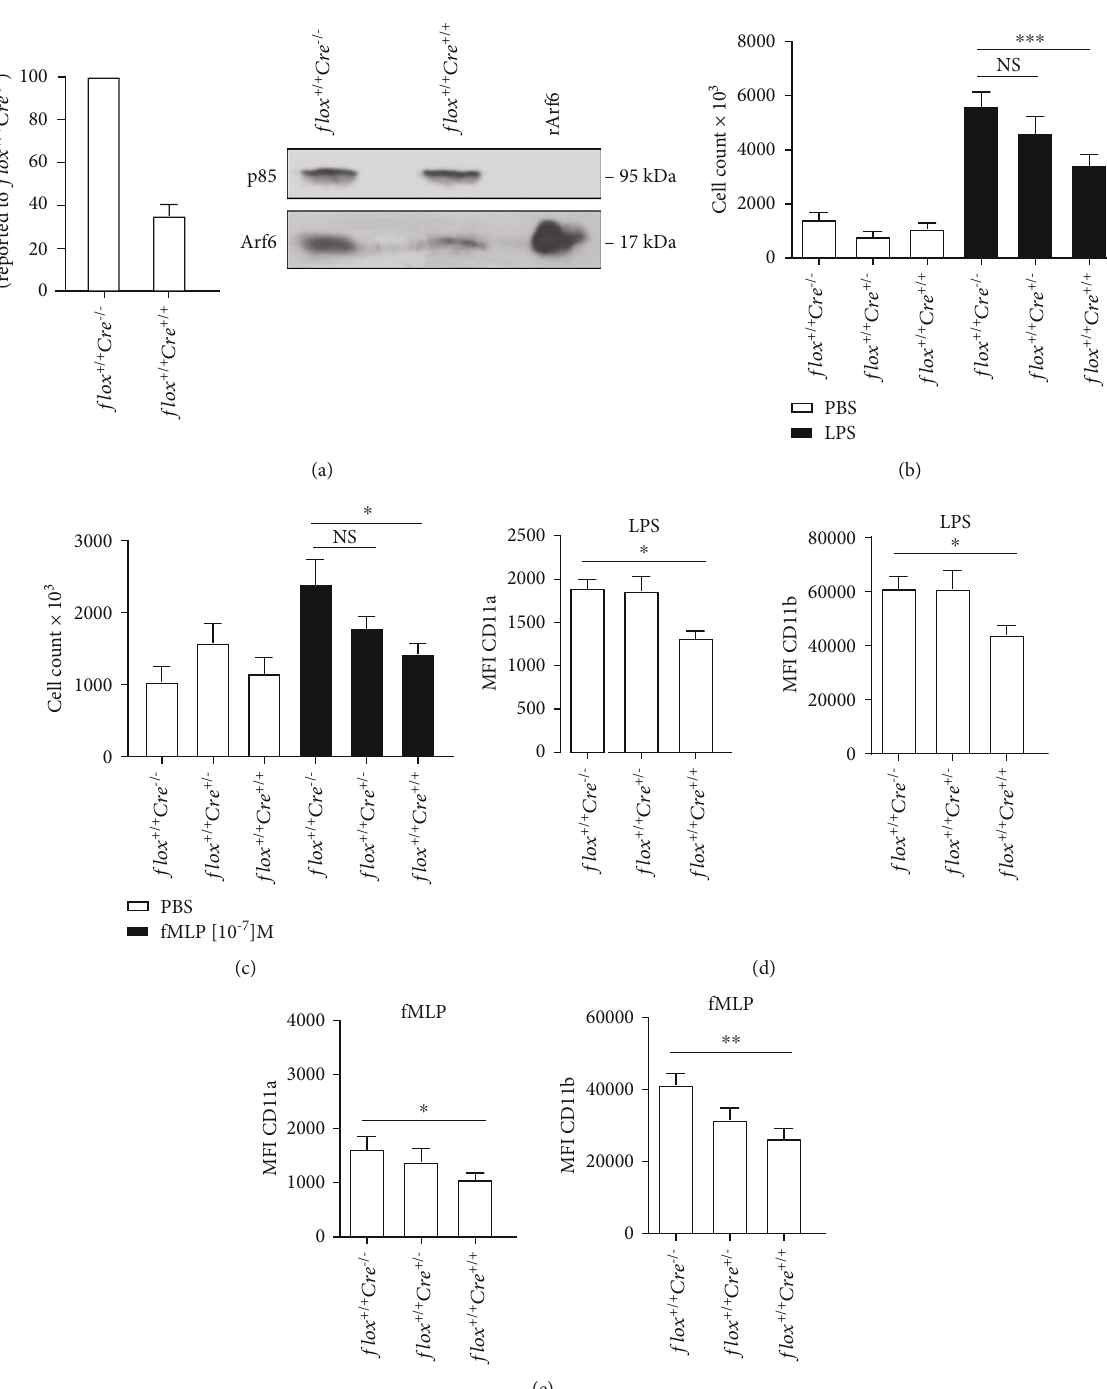
Figure 5: The deletion of Arf6 reduces PMN migration into the air pouches and cell surface expression of CD11a (LFA-1) and CD11b (Mac-1). (a) Arf6 expression by PMNs recruited into the mouse air pouches injected with LPS stimulation was analyzed by immunoblotting with Arf6 and PI3 kinase p85 alpha (p85, loading control) antibodies (left panel, n = 3 ). The right panel is a representative blot from 3 independent experiments with similar results. Recombinant Arf6 (rArf6) was used as a positive control. The amounts of PMNs recruited into the mouse air pouches injected with (b) LPS or (c) fMLP for 4 h were assessed (PBS: n = 6 mice; LPS: n = 30 -46 mice; and fMLP n = 28 -36 mice). (d) Ly6G + cells were gated to evaluate cell surface expression of CD11a (left panel) and CD11b (right panel) in PMNs recruited into the mouse air pouches injected with LPS ( n = 6 mice). (e) Cell surface expression of CD11a (left panel) and CD11b (right panel) in PMNs recruited into the mouse air pouches of injected with fMLP ( n = 6 -10